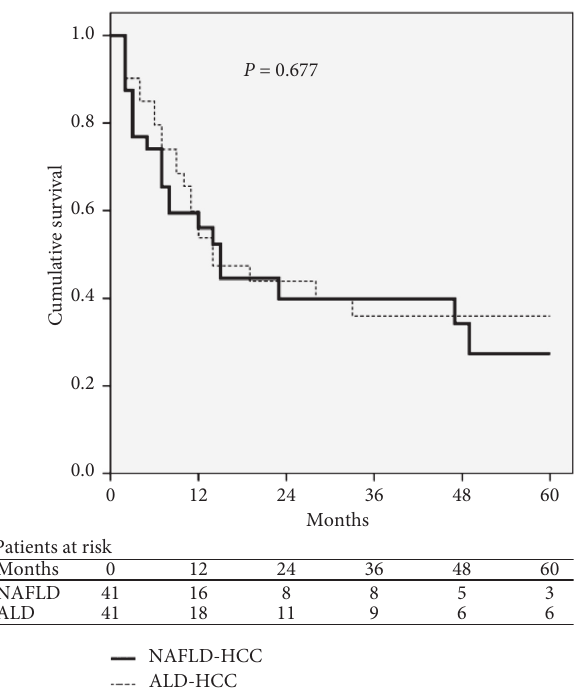
Figure 3: Survival curves of NAFLD-related and ALD-related HCC patients after propensity score matching analysis. ALD: alcoholic liver disease; HCC: hepatocellular carcinoma; NAFLD: nonalcoholic fatty liver